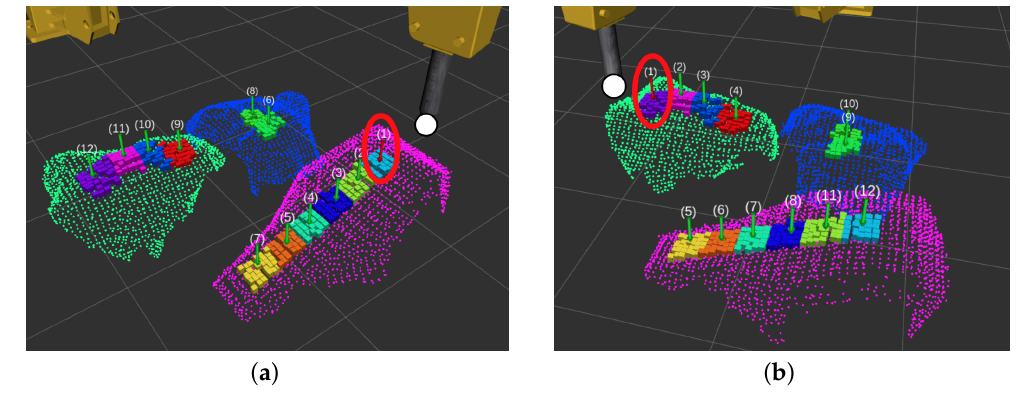
Figure 15. Results of applying Criterion 1 with different hammer states. Arrows represents the generated breaking pose. White point is the end effector pose (in the chisel tip). Circled arrow is the first preferred pose. Numbers are the ranking of each breaking pose. ( a ) Accessibility criterion with arm state with effector near to pink rock. ( b ) Accessibility criterion with effector near to green rock.